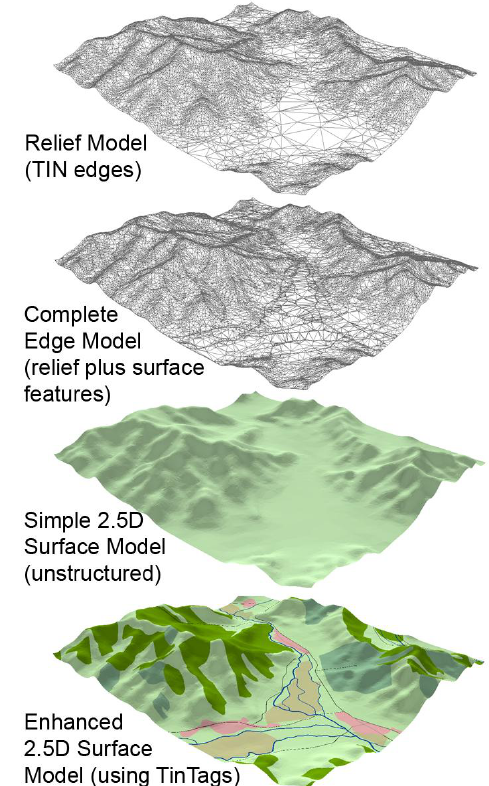
Figure 3: Transfer of the GIS model to a VRML representation for further processing in 3D modelling software.